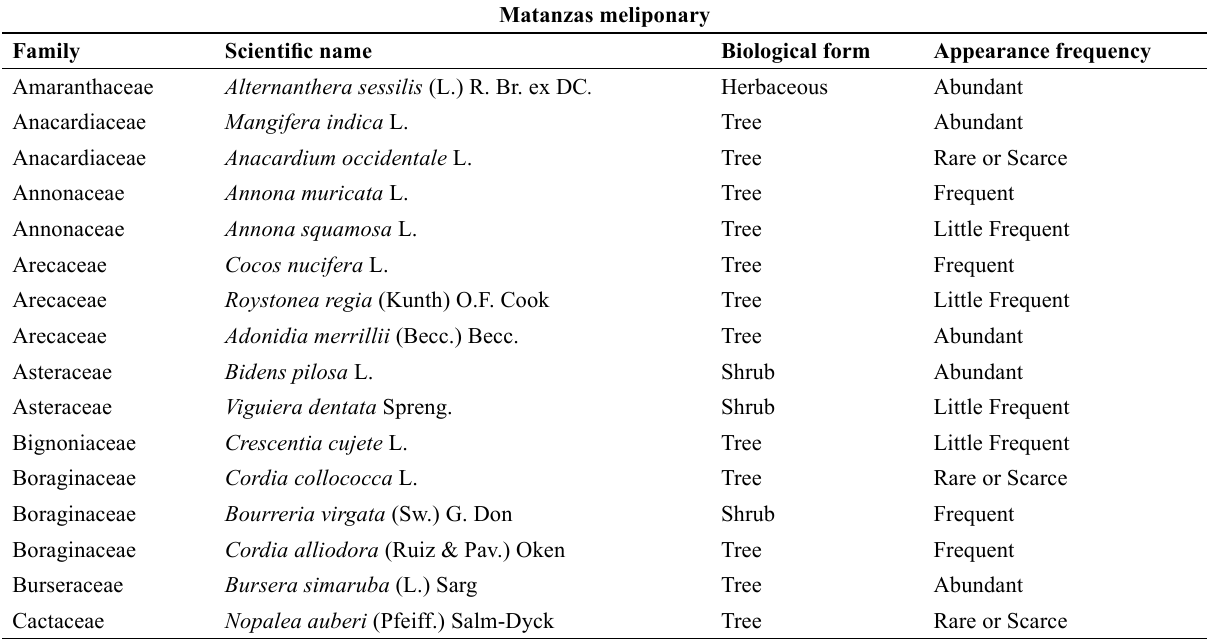
Table 1. Floristic inventory of the Matanzas locality, Cuba,